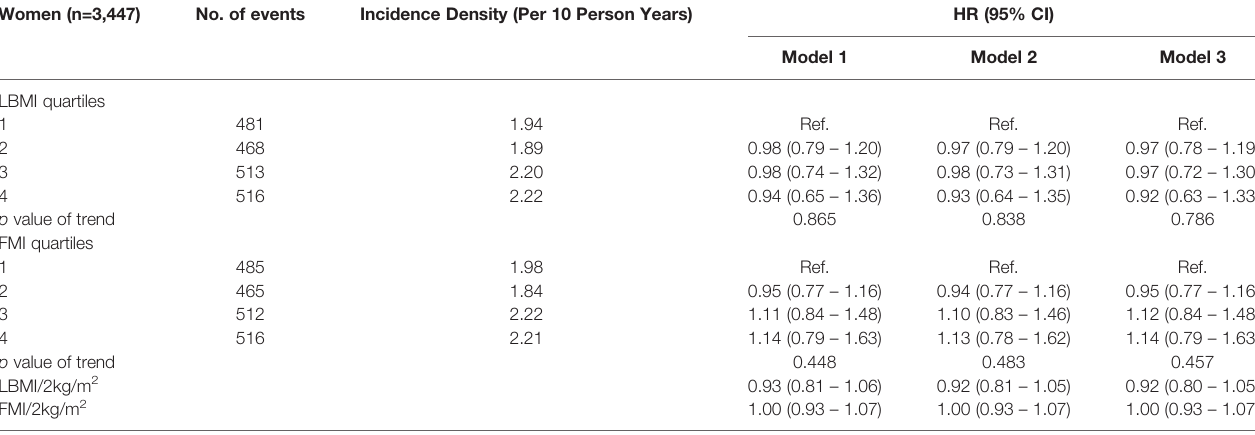
TABLE 3 | Hazard ratios for incident DN, by predicted LBMI and predicted FMI among women with diabetes. Women (n=3,447)